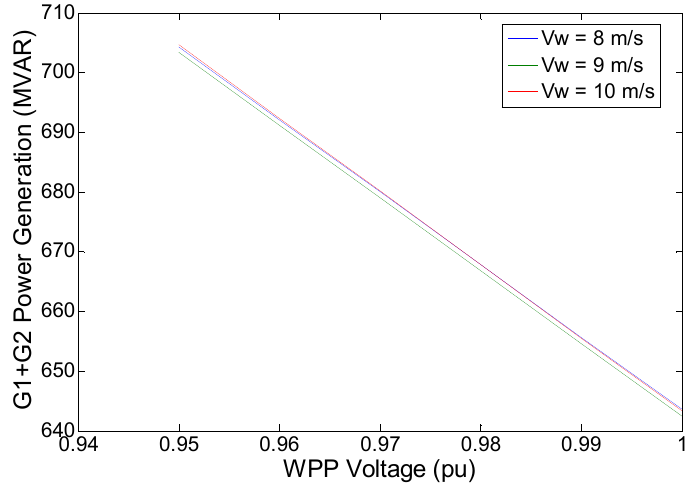
Figure 17. Variation of line active power loss. Figure 18. Variation of line reactive power loss.